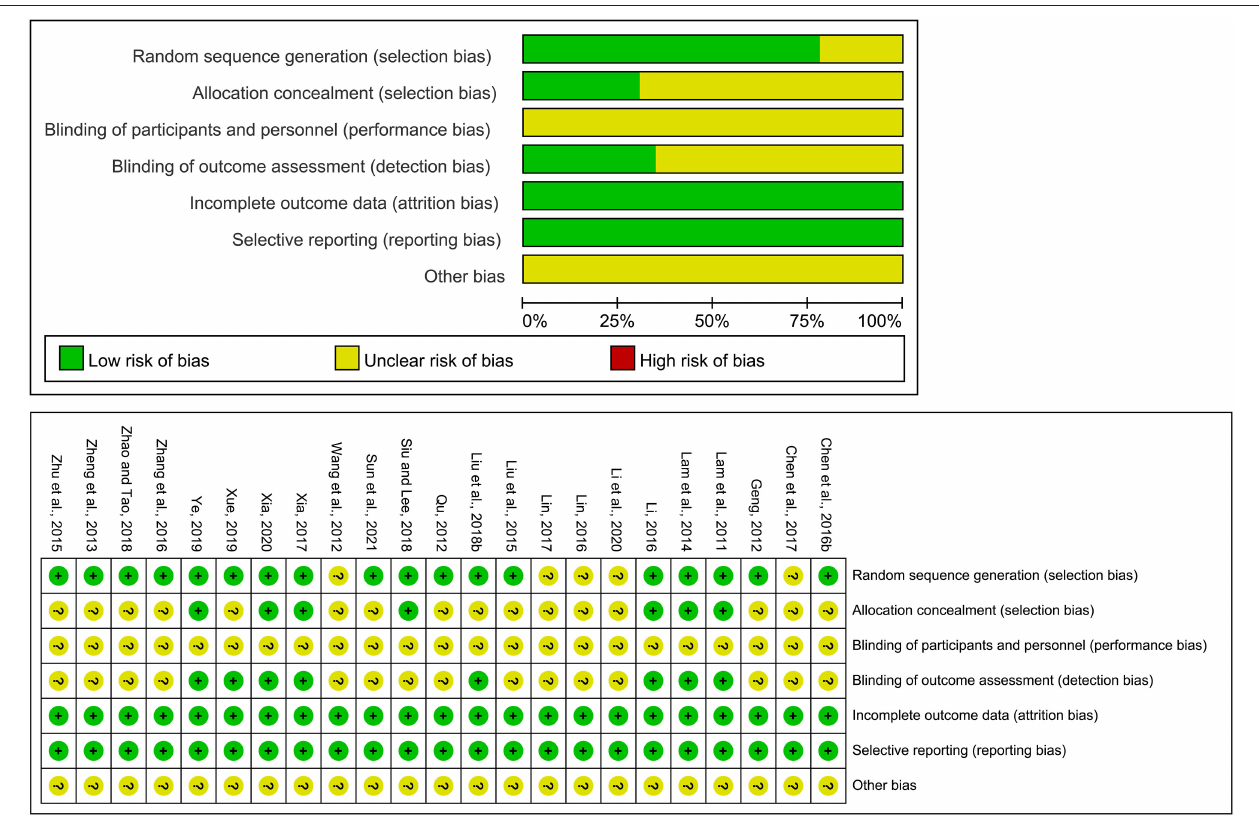
FIGURE 2 | Quality assessment of selected